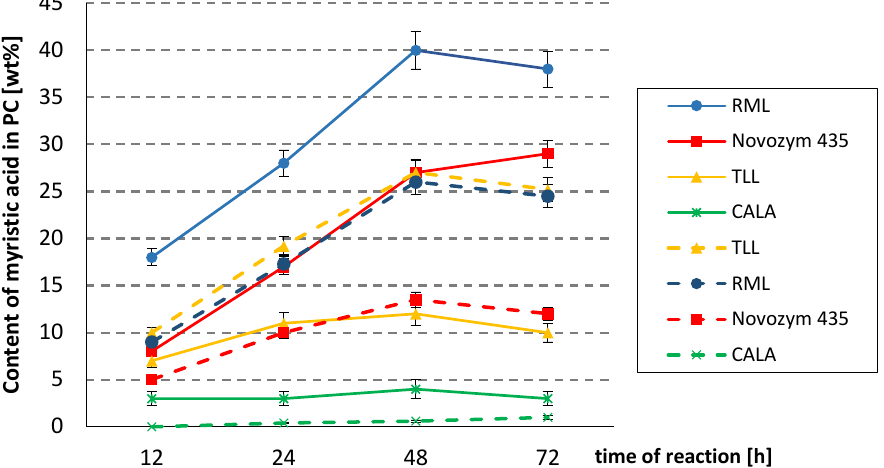
Figure 1. Time courses of different lipases-catalyzed acidolysis ( - - - ) and interesterification ( — ) between egg-yolk phosphatidylcholine (PC) and myristic acid or trimyristin. Reaction condition: temperature, 50–52 °C; PC/acyl donor molar ratio, 1/3; lipase dosage, 30%; solvent, hexane. RML— Rhizomucor miehei lipase; TLL— Thermomyces lanuginosus lipase; CALA— Candida Antarctica .